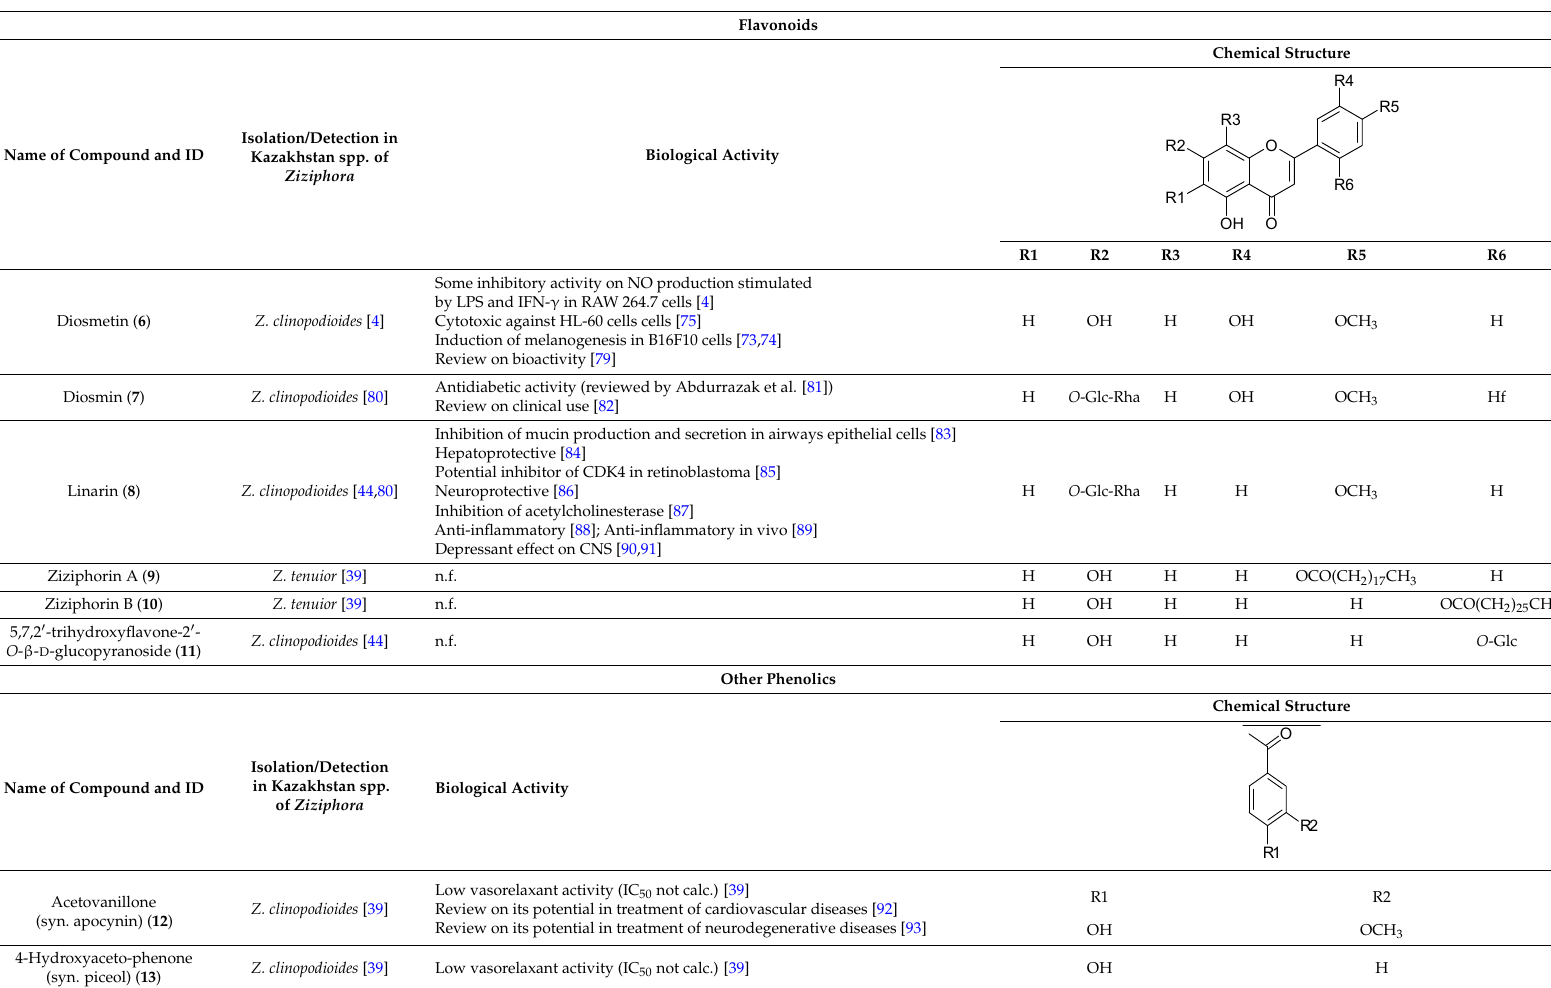
Table 1. Cont. Table 1. Phenolic substances isolated from Kazakhstan Ziziphora species. (N.f.—not found).